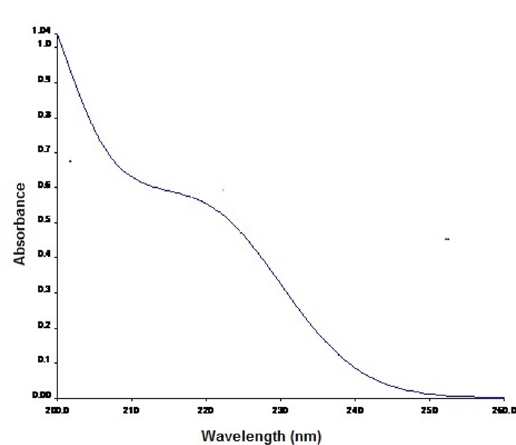
Figure 3. Optical absorption spectrum of MMTG crystal